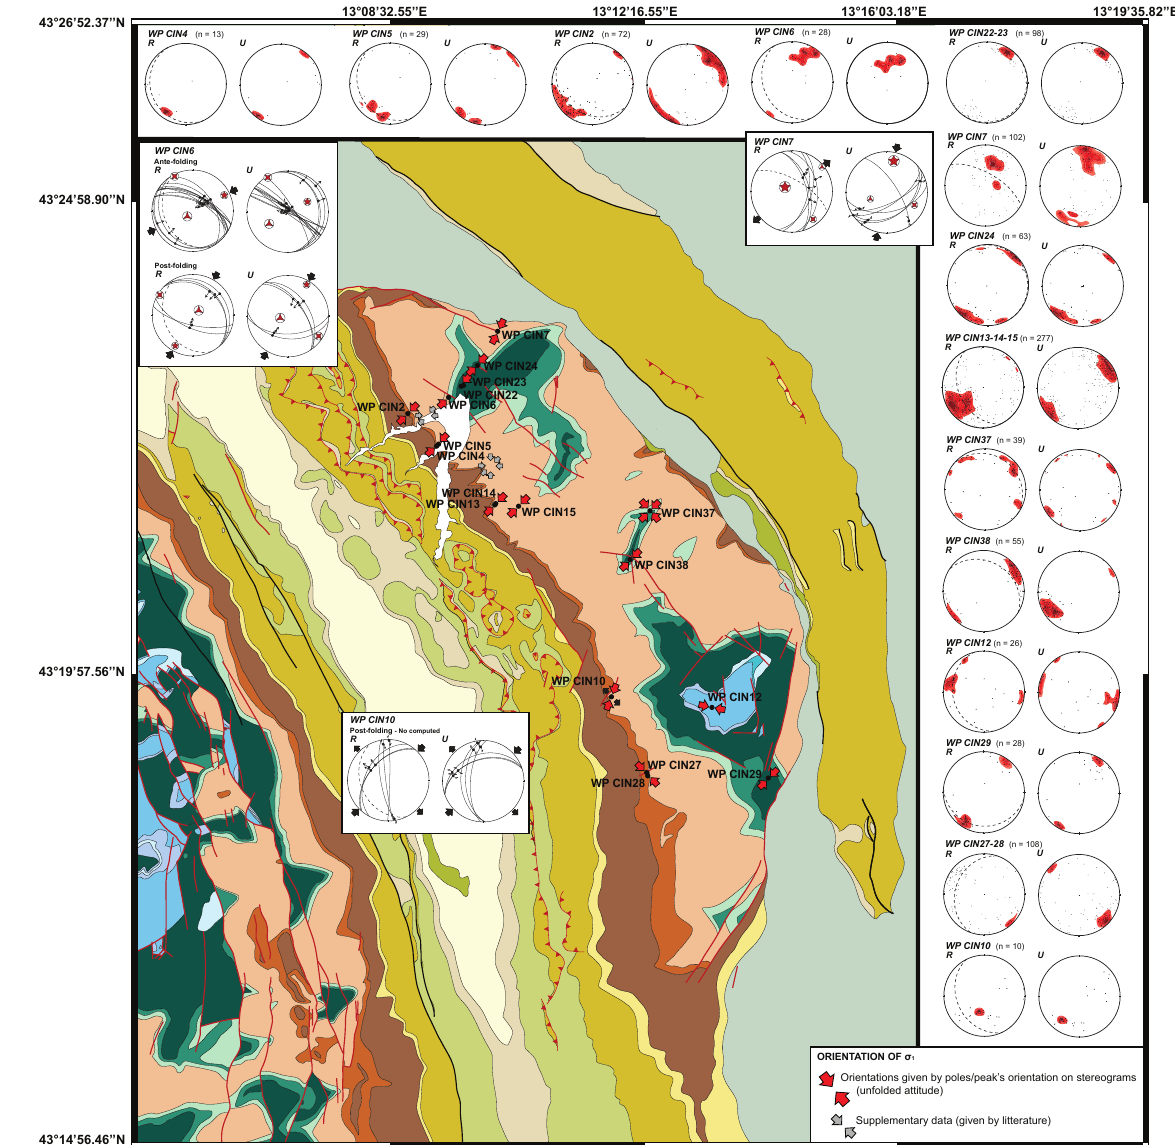
Figure 5. Location and plot of measured tectonic stylolites on the geological map. Each measurement point is associated with two stereodiagrams (lower hemisphere), representing main orientations of tectonic stylolites peaks measured (current and unfolded attitude). On each stereodiagram, the bedding is reported as dashed lines, and peaks orientation (i.e., σ 1 orientation) is given by high pole density zones. Stereodiagrams with fault-slip data and principal stress axes are also